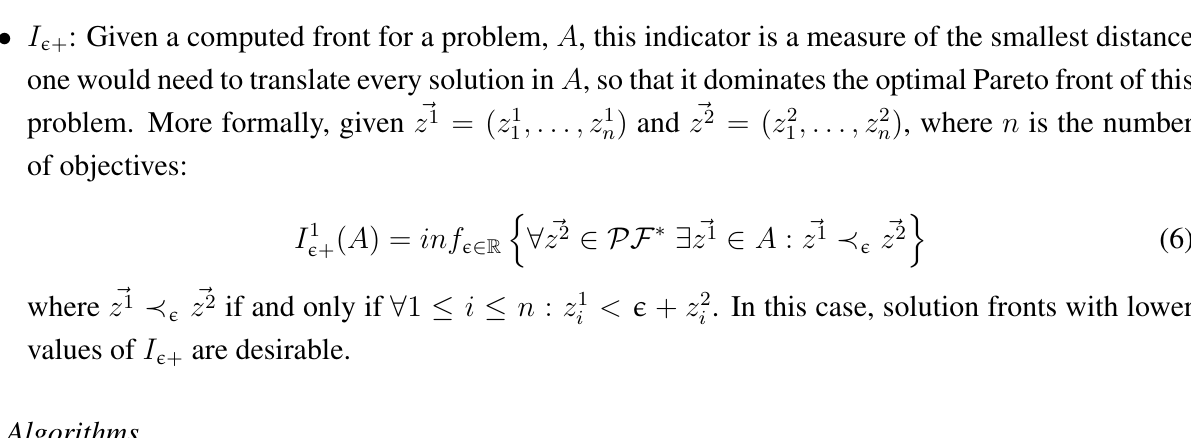
Figure 2. The hyper-volume (delimited by the dotted line) enclosed by the non-dominated solutions. A , B , and C are non-dominated solutions in a set Q = { A, B, C } . For each solution i ∈ Q , a hypercube v is constructed with a reference point W and the solution i as i the diagonal corners of the hypercube. The reference point W can be found by constructing a vector of worst objective function